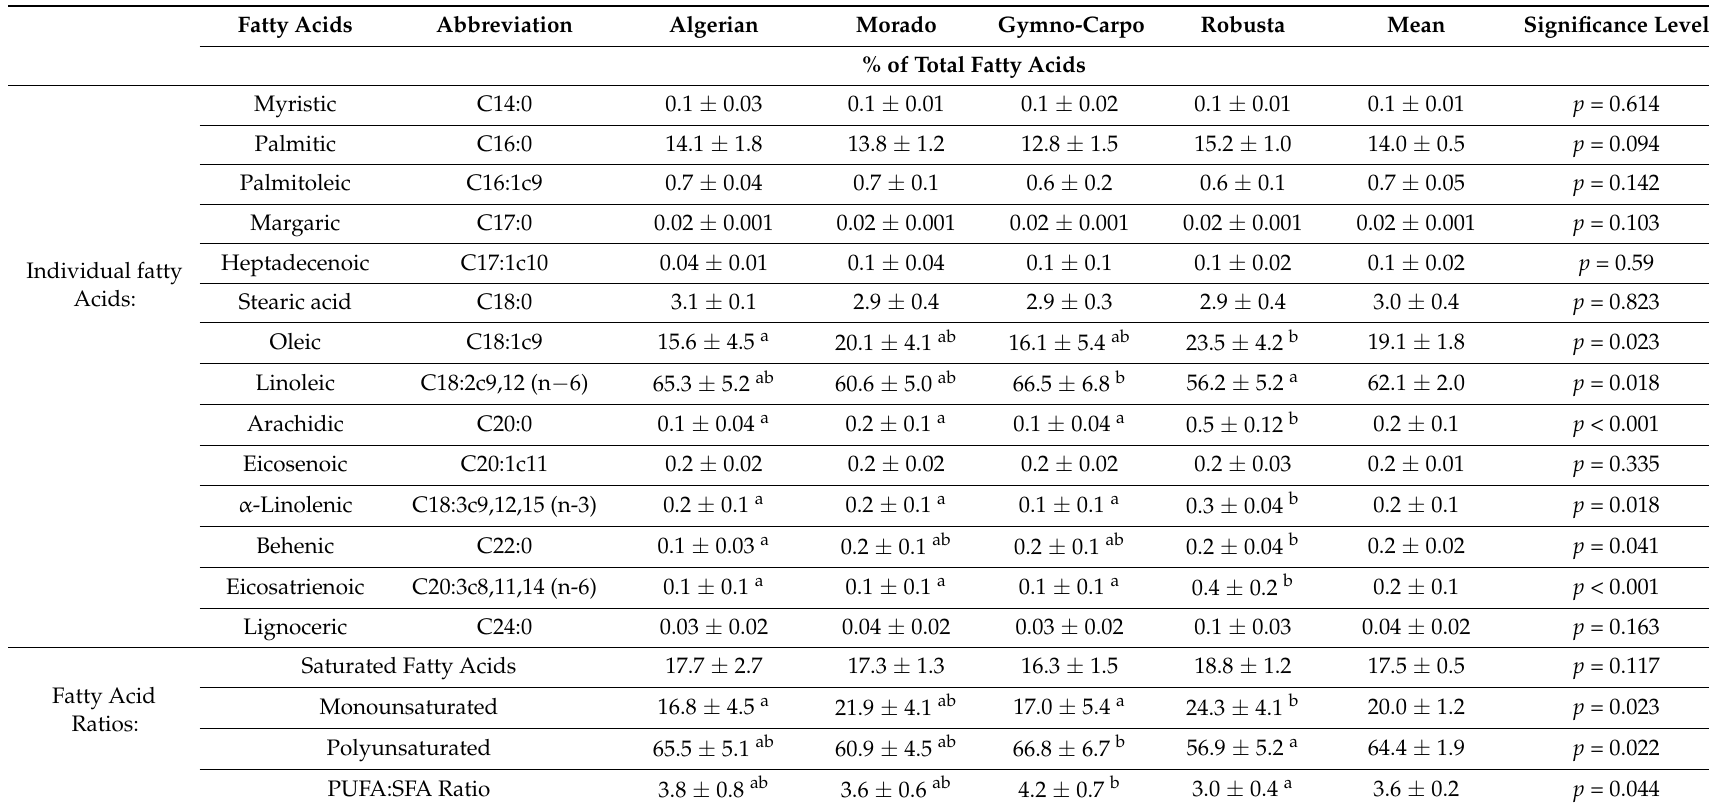
Table 2. Fatty acid content (% of total extractable fat) and ratios of freeze-dried mucilage powders extracted from four cactus pear cultivars harvested from cladodes over six months (February, April, May, June, July and